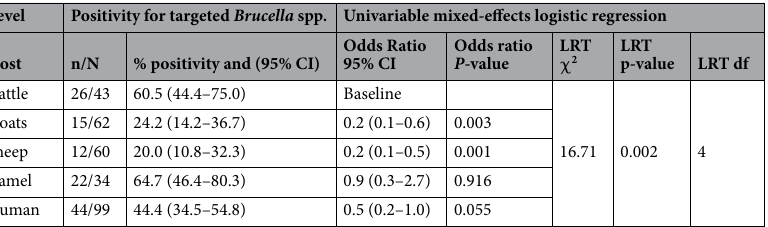
Table 5. Summary of mixed-effects logistic regression models of Brucella abortus status in different host species. Location icc = 0.10. CI confidence interval, LRT χ 2 Likelihood Ratio Test Chi-square value, P-value according to Pearson Chi-square test, n number of positives, N total number tested.